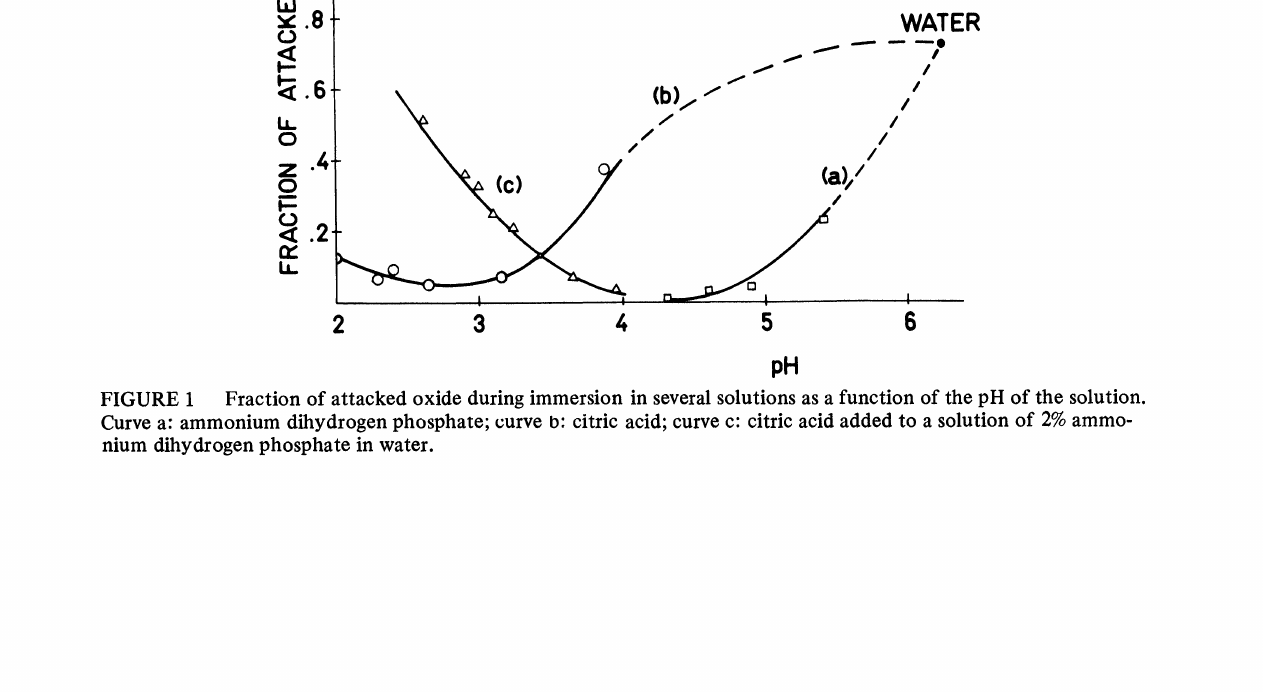
shows the fraction of oxide attacked during the 5 min immersion in the hot ADP solution as a